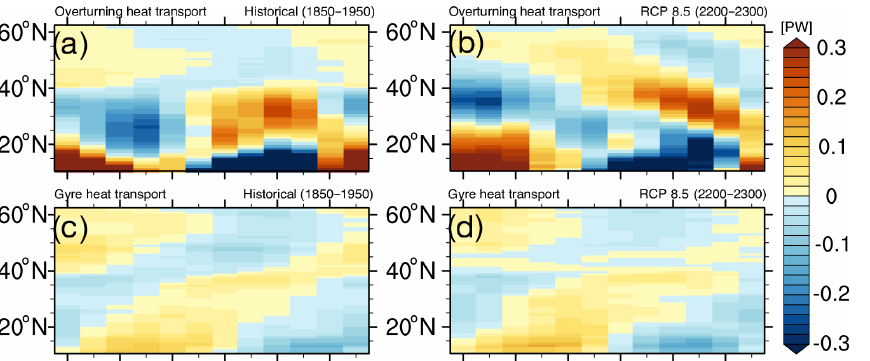
Figure 9. The seasonal cycle of (a–b) the overturning component and (c–d) the gyre component (in PW) in the historical simulation (1850– 1950, left panel) and RCP 8.5 (2200–2300, right panel). Shown are anomalies relative to the annual mean at every latitude. Contour interval is